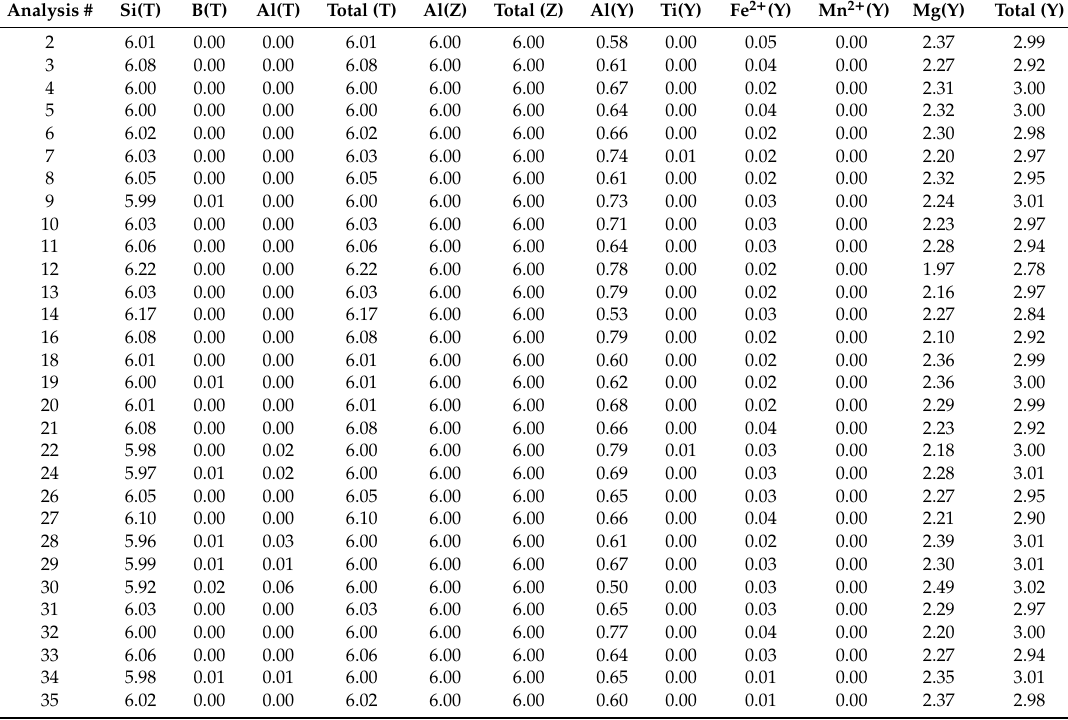
Table 2. Structural formula of tourmaline T1 (T, Z and Y sites) calculated with the WinTcac software [48]. Analysis